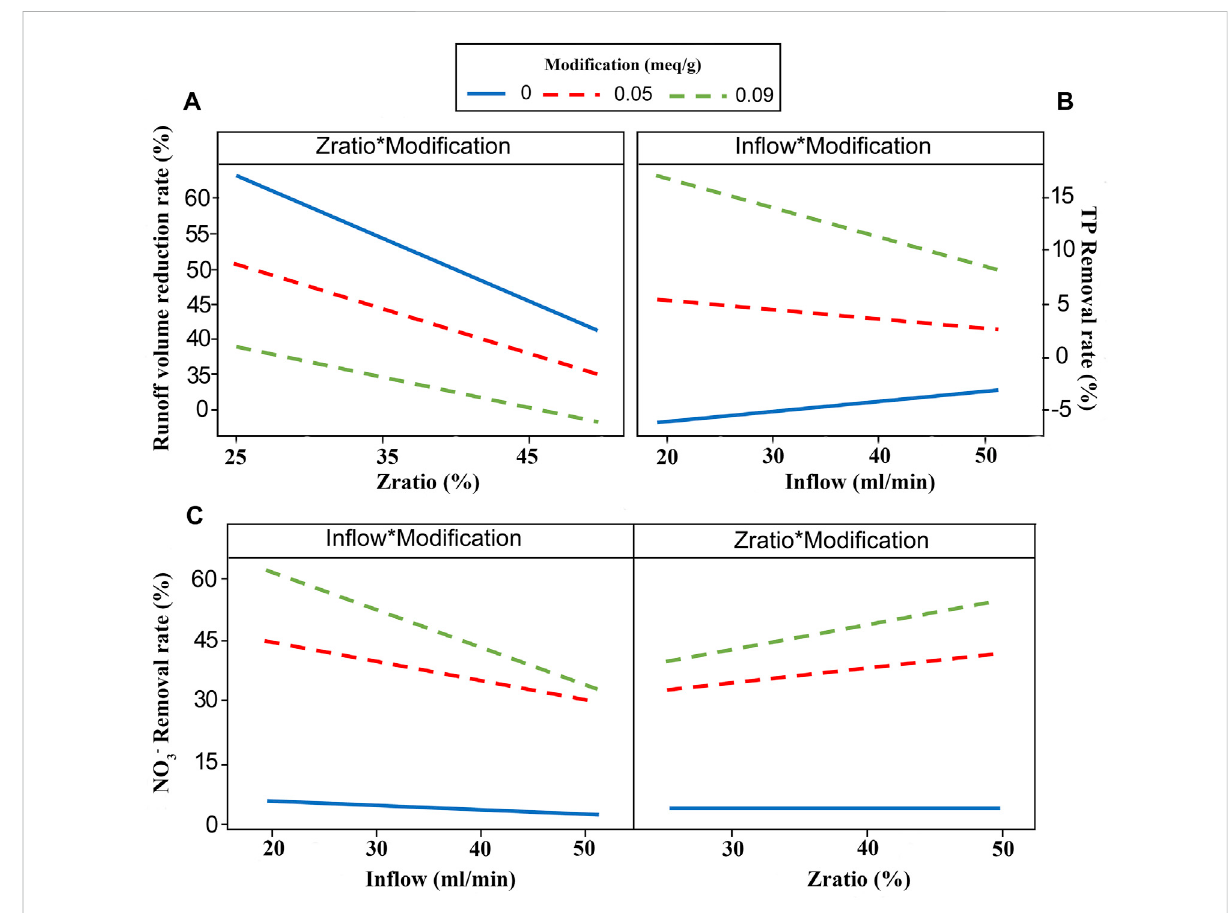
FIGURE 7 In fl uencing factor interaction plot of (A) runoff volume reduction rate, (B) TP removal rate, and (C) NO 3 − -N removal